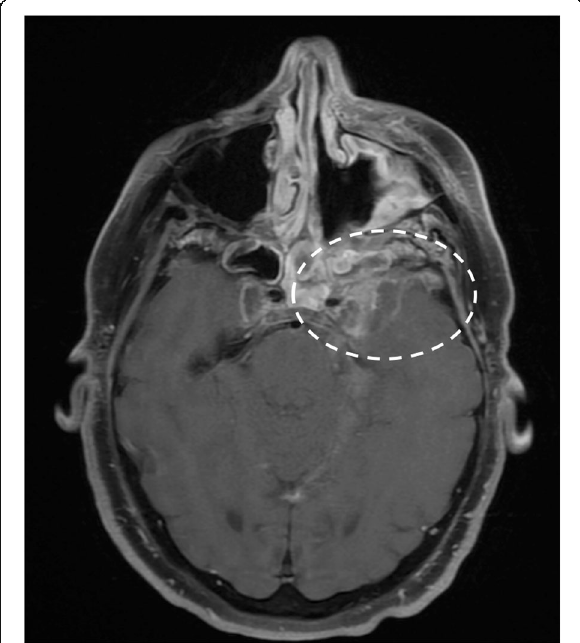
Fig. 20 Perineural spread of tumor. Patient with squamous carcinoma of the retromolar trigone. MRI T1-weighted post- gadolinium image shows diffuse neoplastic enhancement in the left pterygopalatine fossa, cavernous sinus and Meckel ’ s cave (dotted